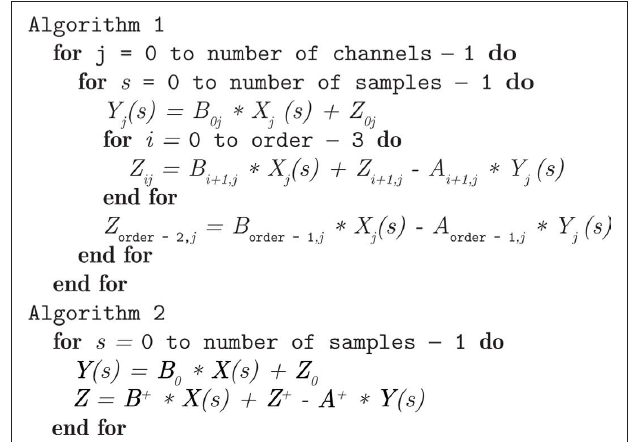
FiGUre 2 | Pseudo code of the two algorithms for the direct form ii transposed iir filter, sequential channels (Algorithm 1) and vectorized channels and filter order (Algorithm 2). Bold faced variables are vectors of size the number of channels, subscripts j give elements of these vectors, and the * operation corresponds to element-wise multiplication. The input is X ( s ) and the output is Y ( s ), that is X ( s ) is the sample in channel j at time s j and similarly for Y ( s ). A and B are the parameters of the filter (which can be i i different for each channel), and the Z are a set of internal variables. Written i without indices, A,B,Z refer to two-dimensional arrays, and the operations over these 2D arrays vectorize over both channels and the order of the filter. The notation Z + refers to a shift with respect to the filter order index, so that Z Z i i + = . The variable “order” is the order of the filter. For Algorithm 2, in + 1 Python, the code reads almost directly as above. In C++ on the CPU, it reads as above but each line with a vector operation has a loop. On the GPU it reads as above, but is evaluated in parallel with one thread per channel and a loop over the